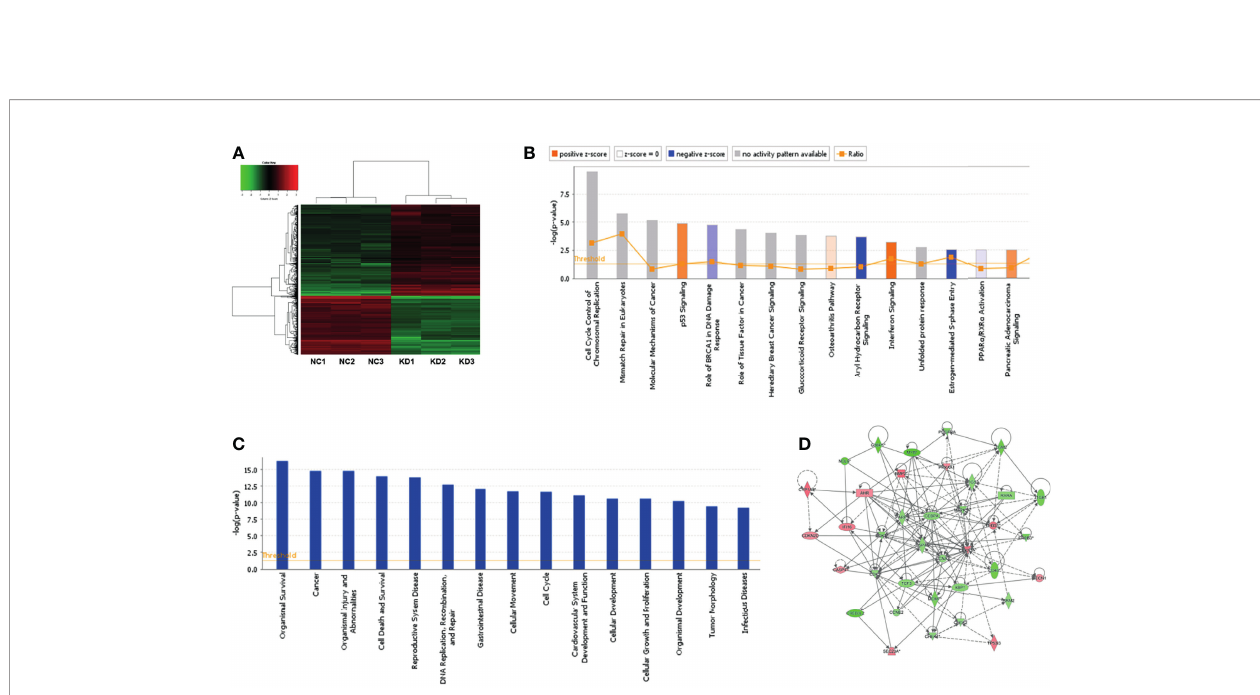
FIGURE 6 | Microarray assay and IPA analysis following NOL6 knockdown. (A) The clusters diagram showed the differentially expressed genes after NOL6 inhibited. The red plots indicated the up-regulated genes, while the green plots indicated the down-regulated genes. (B) Top 15 classical signaling pathways following NOL6 knockdown were list in the canonical pathway histogram. All signaling pathways were sorted by – Log(P-value), the orange histogram represented apparently activated and the blue histogram represented apparently inhibited. (C) Gene enrichment of disease and function following NOL6 knockdown. All diseases and functions are sorted by -log (p-value). (D) The gene interaction network shows the interaction between downstream molecules after NOL6 silencing. The red plots represented up-regulated genes, the green plots represented down-regulated genes, and the intensity of the color indicates degree of variation. Solid lines represent direct interaction, whereas dotted line represent indirect interaction.